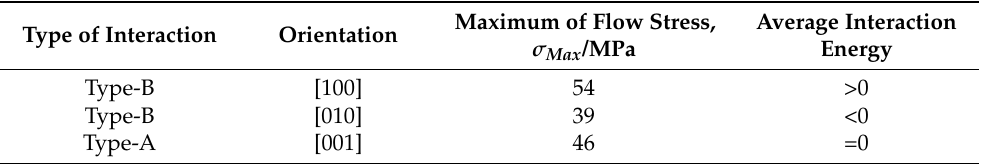
Table 2. Orientation dependent hardening of edge dislocation overcoming <001> rod precipitates ex- pressed as the maximum values of shear stresses observed in the dislocation slip planes at z/|b| = 0. Maximum of Flow Stress, Average Interaction Type of Interaction Orientation Energy σ Max /MPa Type-B [100] 54 >0 Type-B [010] 39 <0 Type-A [001] 46